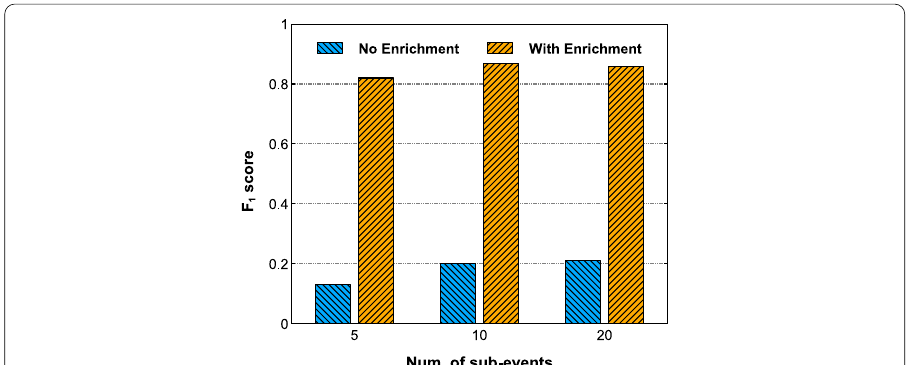
Fig. 8 Comparison of the F1-score obtained by SEDOM-DD with and without the enrichment of